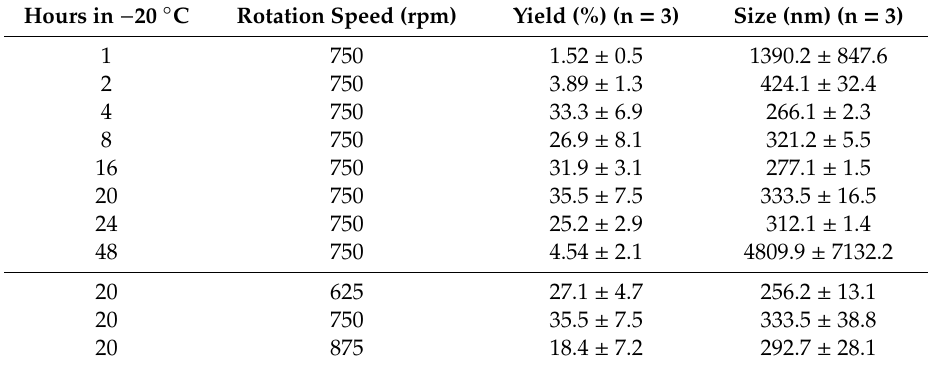
Table 1. E ff ect of varying storage times and rotation speeds on percentage yield and size (n =